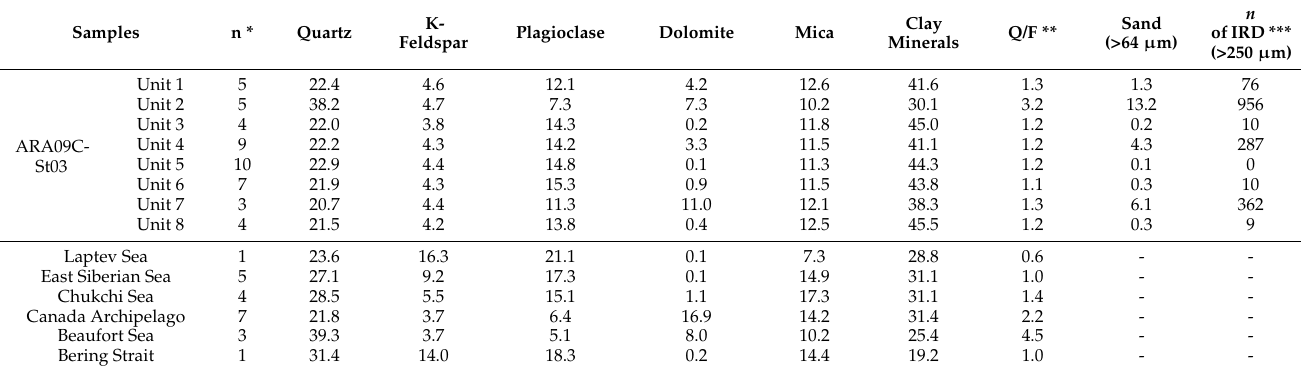
Table 1. Average bulk mineral compositions (%), sand content (%) and number of IRD of core ARA09C-St03 and potential provenances from Darby et al.